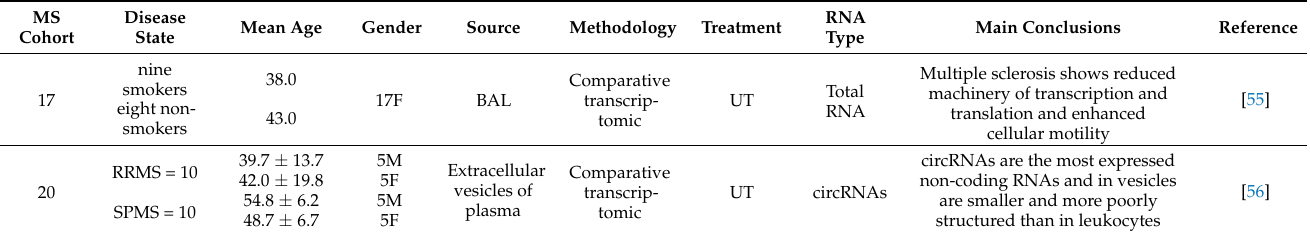
Table 6. Overview of the studies exploring transcriptomes in other